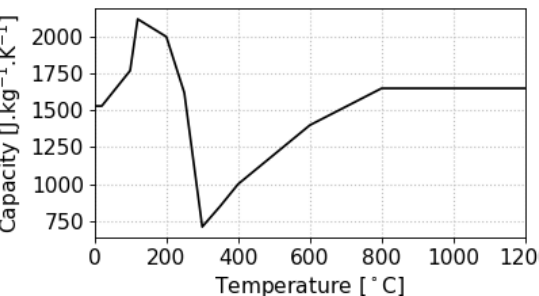
Figure 8. EC5 timber specific heat capacity.